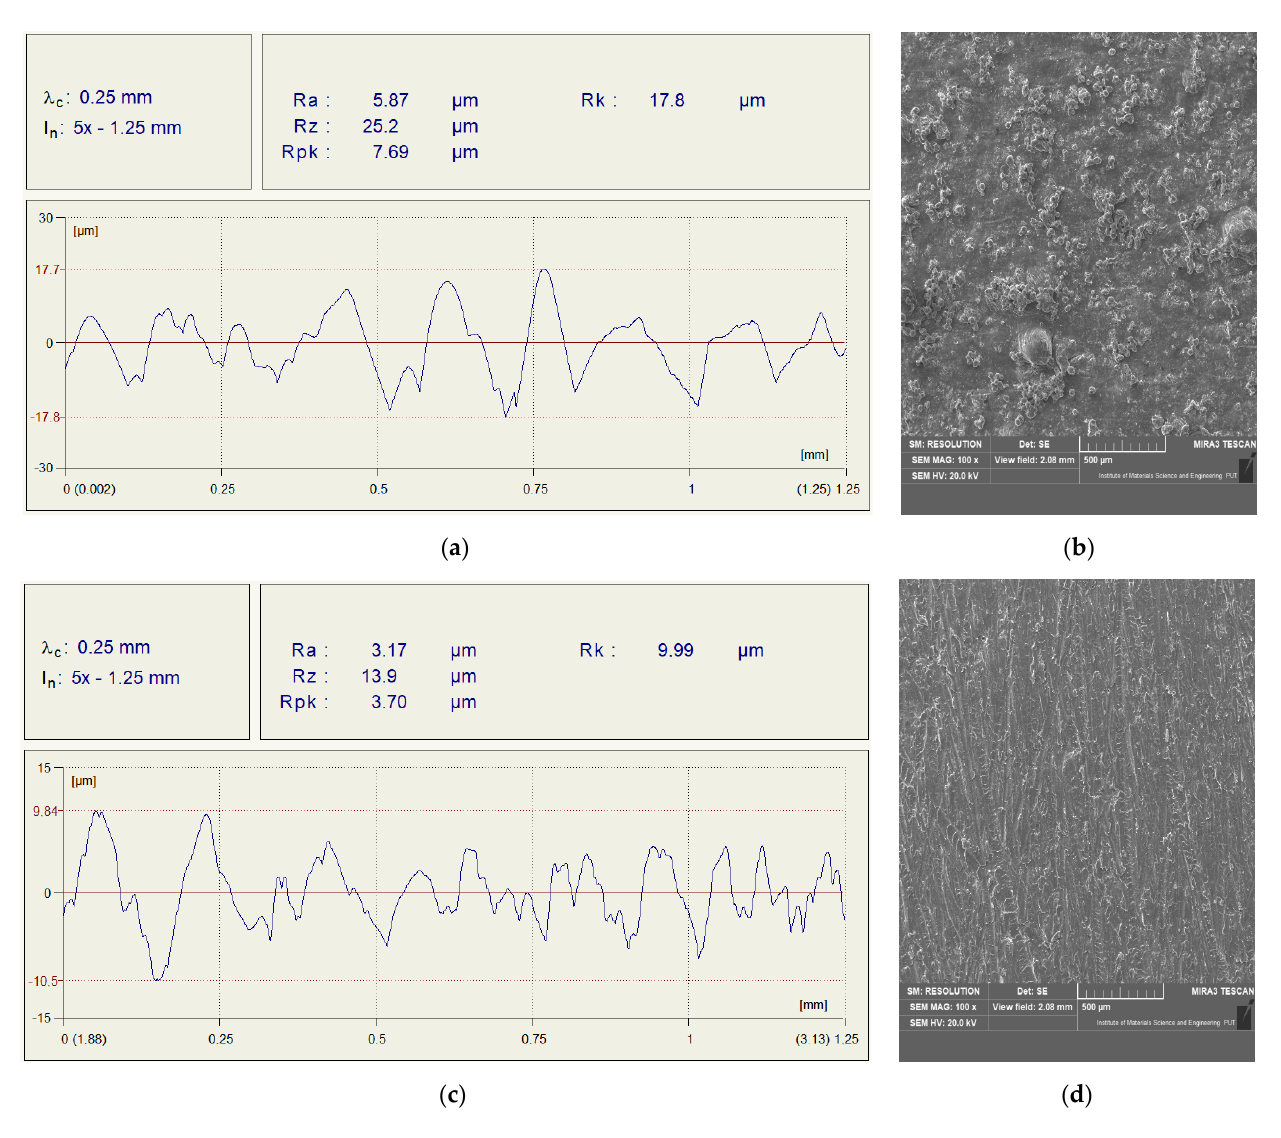
Figure 2. Assessment of the surface layer before the bonding process; ( a ) surface roughness profile after sandblasting, ( b ) view of the surface structure after sandblasting, ( c ) surface roughness profile after sanding with P80 abrasive paper, ( d ) view of the surface structure after sanding with P80 abrasive paper.